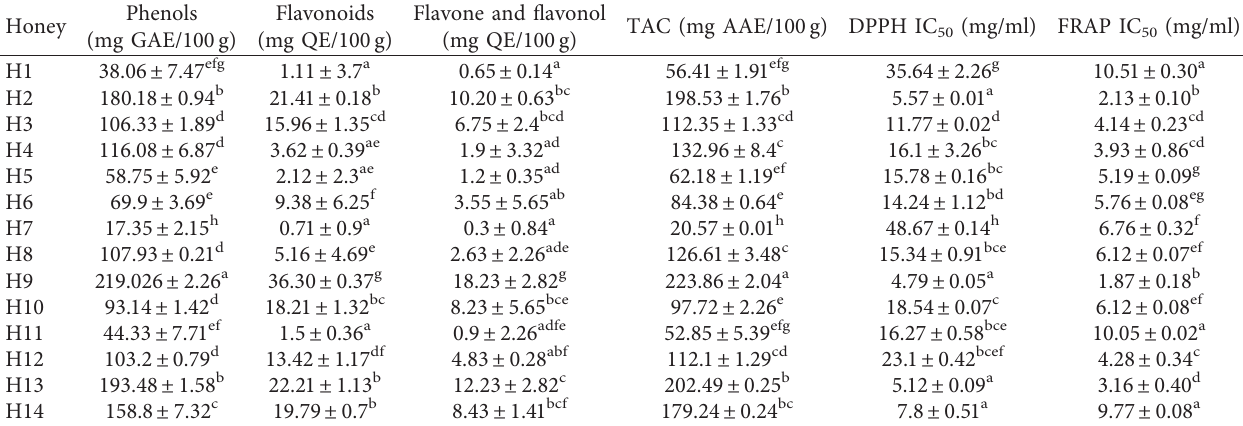
Table 5: The content of phenols, flavonoids, flavone, and flavonol, total antioxidant capacity (TAC), and antioxidant activity (DPPH and reducing power) of Moroccan honeys.